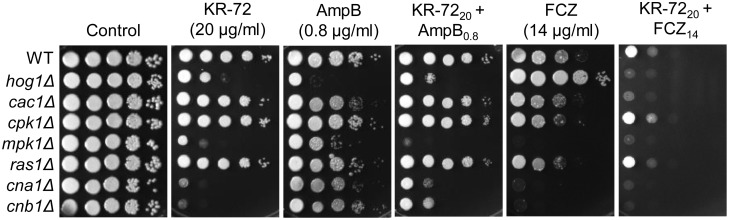
KR-72 modulated azole susceptibility in C. neoformans.
Each C. neoformans strain [WT (H99), hog1Δ (YSB64), cac1Δ (YSB42), cpk1Δ (YSB127), mpk1Δ (KK3), ras1Δ (YSB53), cna1Δ (KK1), and cnb1Δ (KK2)] was grown overnight at 30°C in liquid YPD medium, 10-fold serially diluted (1 to 104 dilutions), and spotted (3 µL) onto YPD agar containing the indicated concentrations of KR-72 (20 µg/mL, KR-7220), amphotericin B (0.8 µg/mL, AmpB0.8), fluconazole (14 µg/mL, FCZ14), or a combination of both (KR-7220+AmpB0.8, KR-7220+FCZ14). Cells were incubated at 30°C for 3 days and photographed.